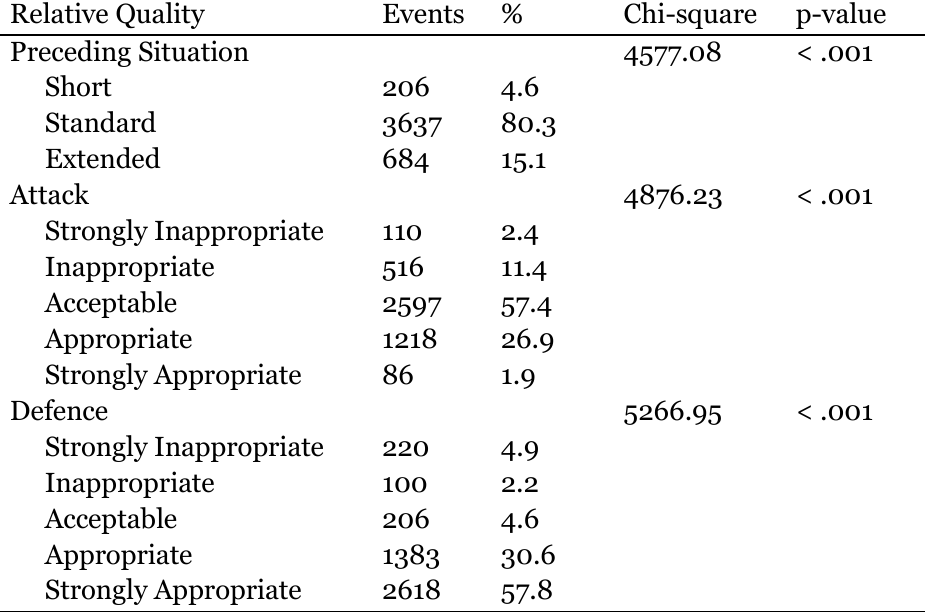
Table 3 . Frequency distribution of Scal-Go indicators during 24 elite goalball